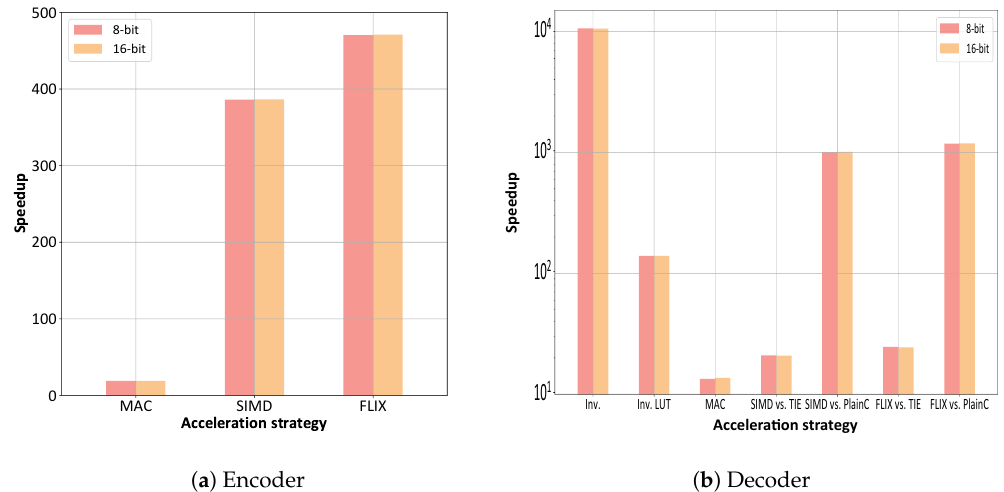
Figure 6. Speedups for different acceleration strategies with respect to the plain C implementation. For the decoding, we considered in part ( b ) the following speedups: “Inv., Mult.” is number of clock cycles for “Plain C Inv.” divided by number of clock cycles for “TIE Inv.”; “Inv., LUT” is number of clock cycles for “Plain C Inv. LUT” divided by number of clock cycles for “TIE Inv.”; “SIMD/FLIX vs. TIE” is number of clock cycles for (“TIE Inv” + “TIE MAC”) divided by number of clock cycles for “SIMD/FLIX” (complete decoding); “SIMD/FLIX vs. Plain C” is number of clock cycles for (“Plain C Inv. LUT” + “Plain C MAC”) divided by number of clock cycles for “SIMD/FLIX” (complete